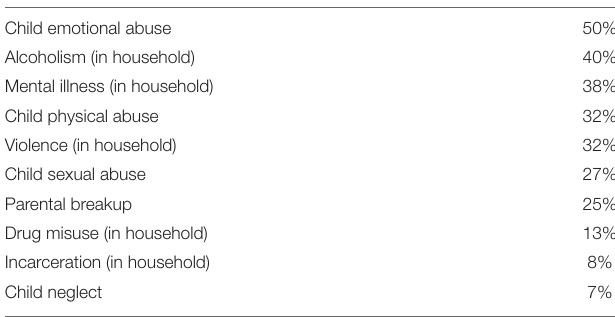
TABLE 2 | Prevalence of ACEs, by type, experienced by study service users (%) ( n = 60)